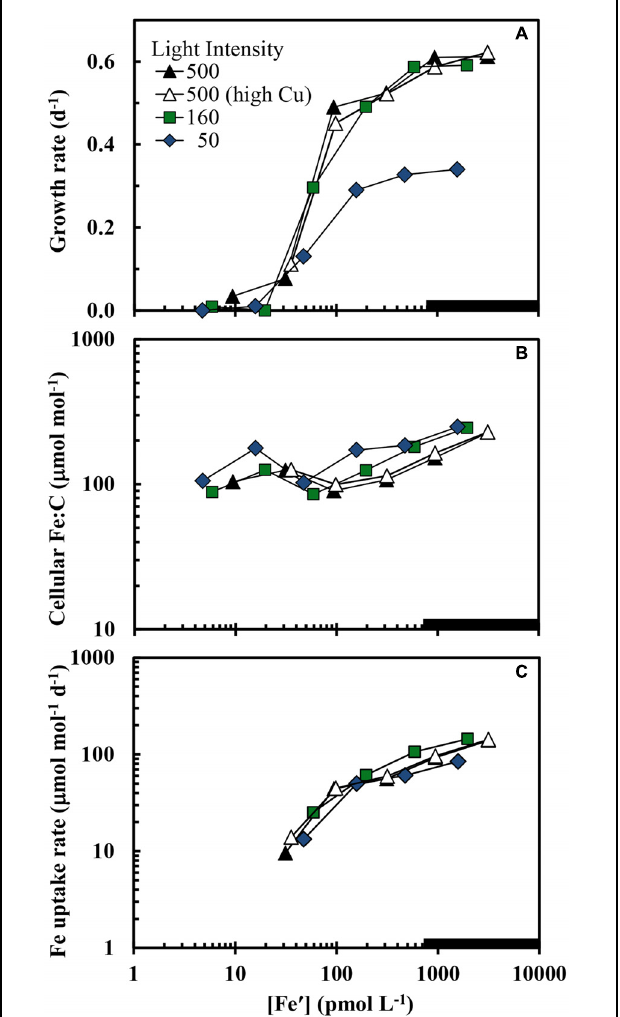
FIGURE 1 | (A) Specific growth rate, (B) cellular Fe:C ratio, and (C) carbon normalized cellular iron uptake rate ( µ mol [mol C] − 1 d − 1 ) in Synechococcus bacillaris plotted as functions of the average daily concentration of dissolved inorganic ferric hydrolysis species ([Fe (cid:4) ]) in picomolar (pM) units. There were four separate treatments: (1) high light intensity (500 µ mol quanta m − 2 s − 1 ) and low cupric ion concentration ([Cu 2 + ] = 0.16 pM; solid black triangles), (2) high light intensity (500 µ mol quanta m − 2 s − 1 ) and a higher cupric ion concentration ([Cu 2 + ] = 16 pM; open triangles), (3) intermediate light intensity (160 µ mol quanta m − 2 s − 1 ) and low copper ([Cu 2 + ] = 0.16 pM; green squares), and (4) low light intensity (50 µ mol quanta m − 2 s − 1 ) and low copper ([Cu 2 + ] = 0.16 pM; blue diamonds). The thick solid line on the x-axis shows the region where iron hydroxides precipitate (Sunda and Huntsman, 1995). Within this region [Fe (cid:4) ] should no longer continue to increase and the x-axis values indicate proportional increases the total iron